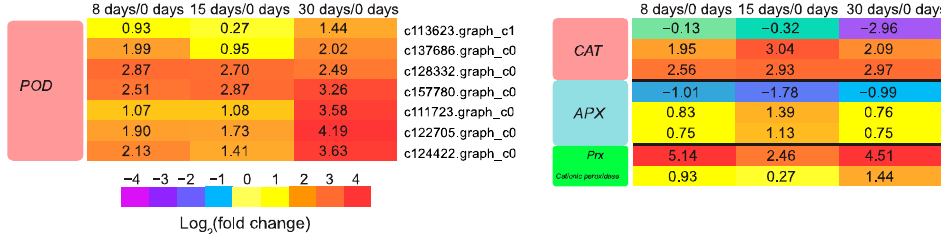
Figure 8. Expression profiles of DEGs involved in ROS scavenging. The values of log 2 fold change are shown in the heat map.